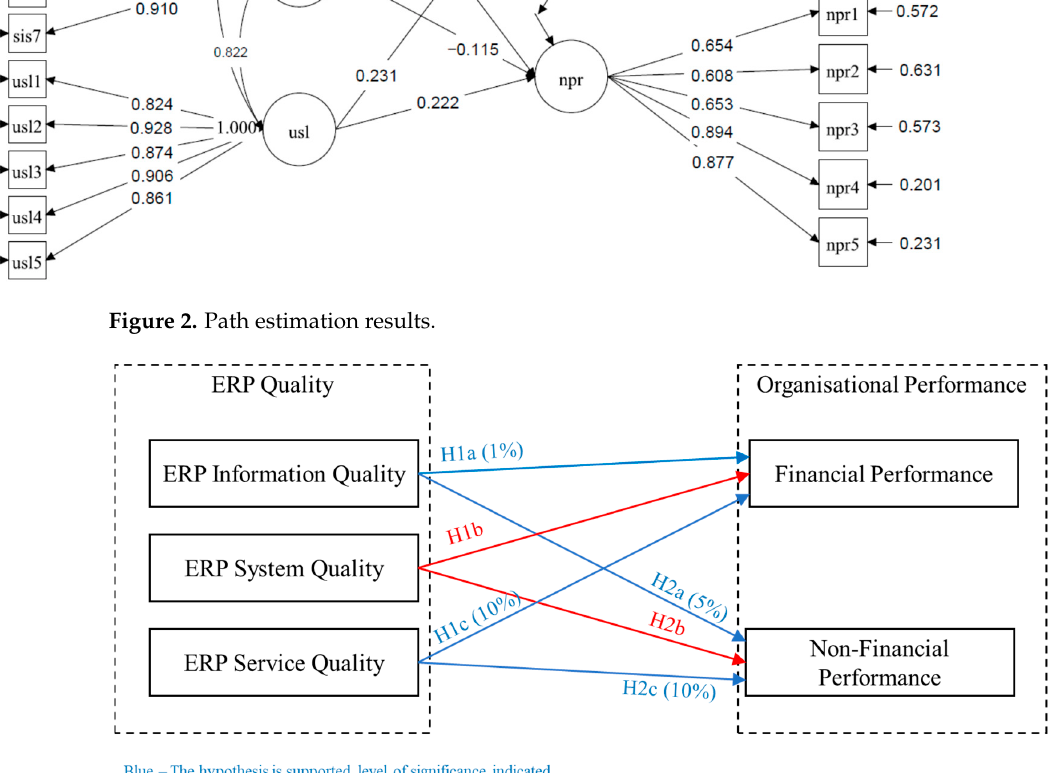
Figure 3. Research model with the results of hypothesis testing.